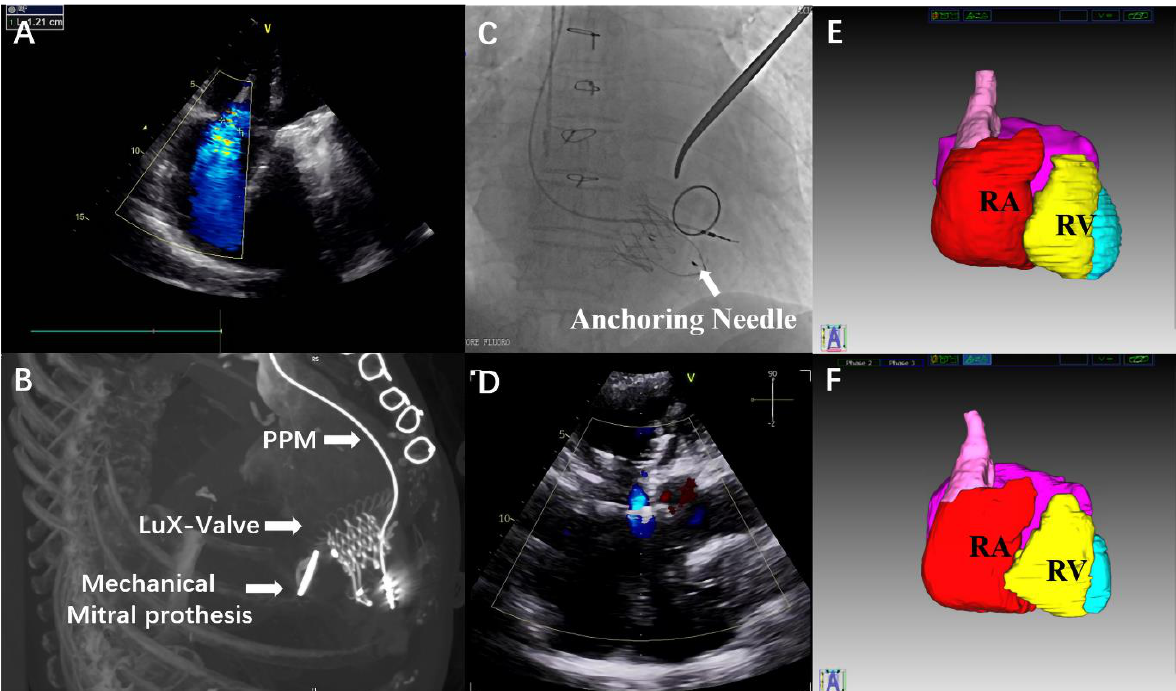
Figure 2. Procedural Steps of LuX-Valve Transatrial Tricuspid Valve Replacement. ( A ) Pre-operative transthoracic echocardiogram discloses severe tricuspid regurgitation. ( B ) Post-operative computed Tomography (CT) reconstruction shows the implants of the patient. ( C ) The fluoroscopy after releasing the anchoring needle. ( D ) A transthoracic echocardiogram shows trivial paravalvular leakage at 4-year follow-up. ( E ) Three-dimensional CT reconstruction of the whole heart with volumetric assessment of RV (shaded yellow). ( F ) Three-dimensional CT reconstruction indicating a slight increase in RV at 4-year follow-up. PPM = permanent pacemaker; RV = right ventricle. Transesophageal echocardiography showed the correct position of the implant, with trivial paravalvular leakage. Right atrial pressure decreased from 20 mmHg preoperatively, to 14 mmHg immediately